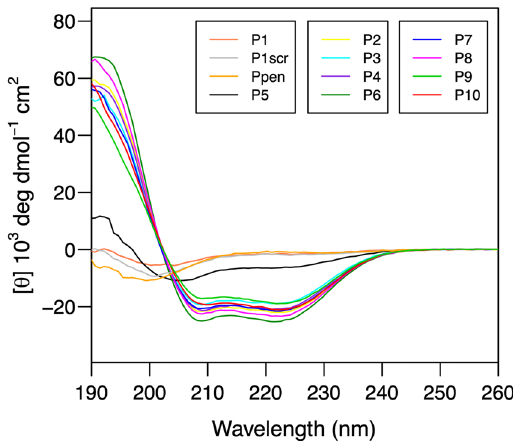
Fig. 2 Far-UV CD spectra of synthesized peptides. Samples of peptides P1 - P10 , P1Scr , and Ppen were prepared at a concentration of 60 µ M in 50 mM sodium phosphate buffer at pH 7.4. CD measurements are reported as molar ellipticity per